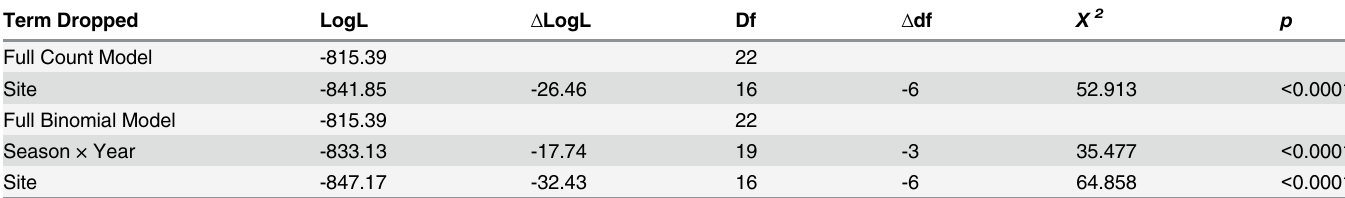
Table 2. Summary of final model results of non-Pocilloporidae spat settlement evaluated by likelihood ratio tests of nested